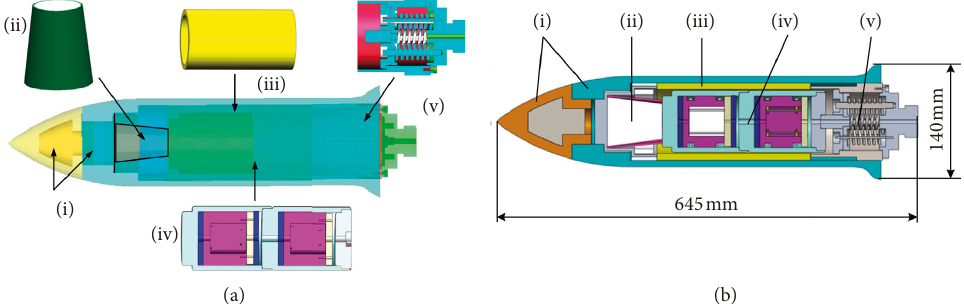
Figure 2: (a) Structural composition of the penetrator; (b) profile of the penetrator. (i) External protection structure, (ii) FTS, (iii) damping layer, (iv) scientific instrumentation, and (iv) damping spring.